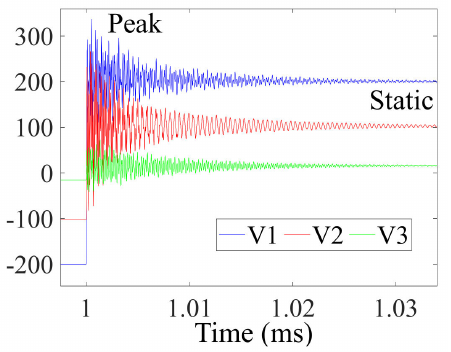
Figure 19. Typical waveform of layer1-to-layer2 voltage drop (C-type).